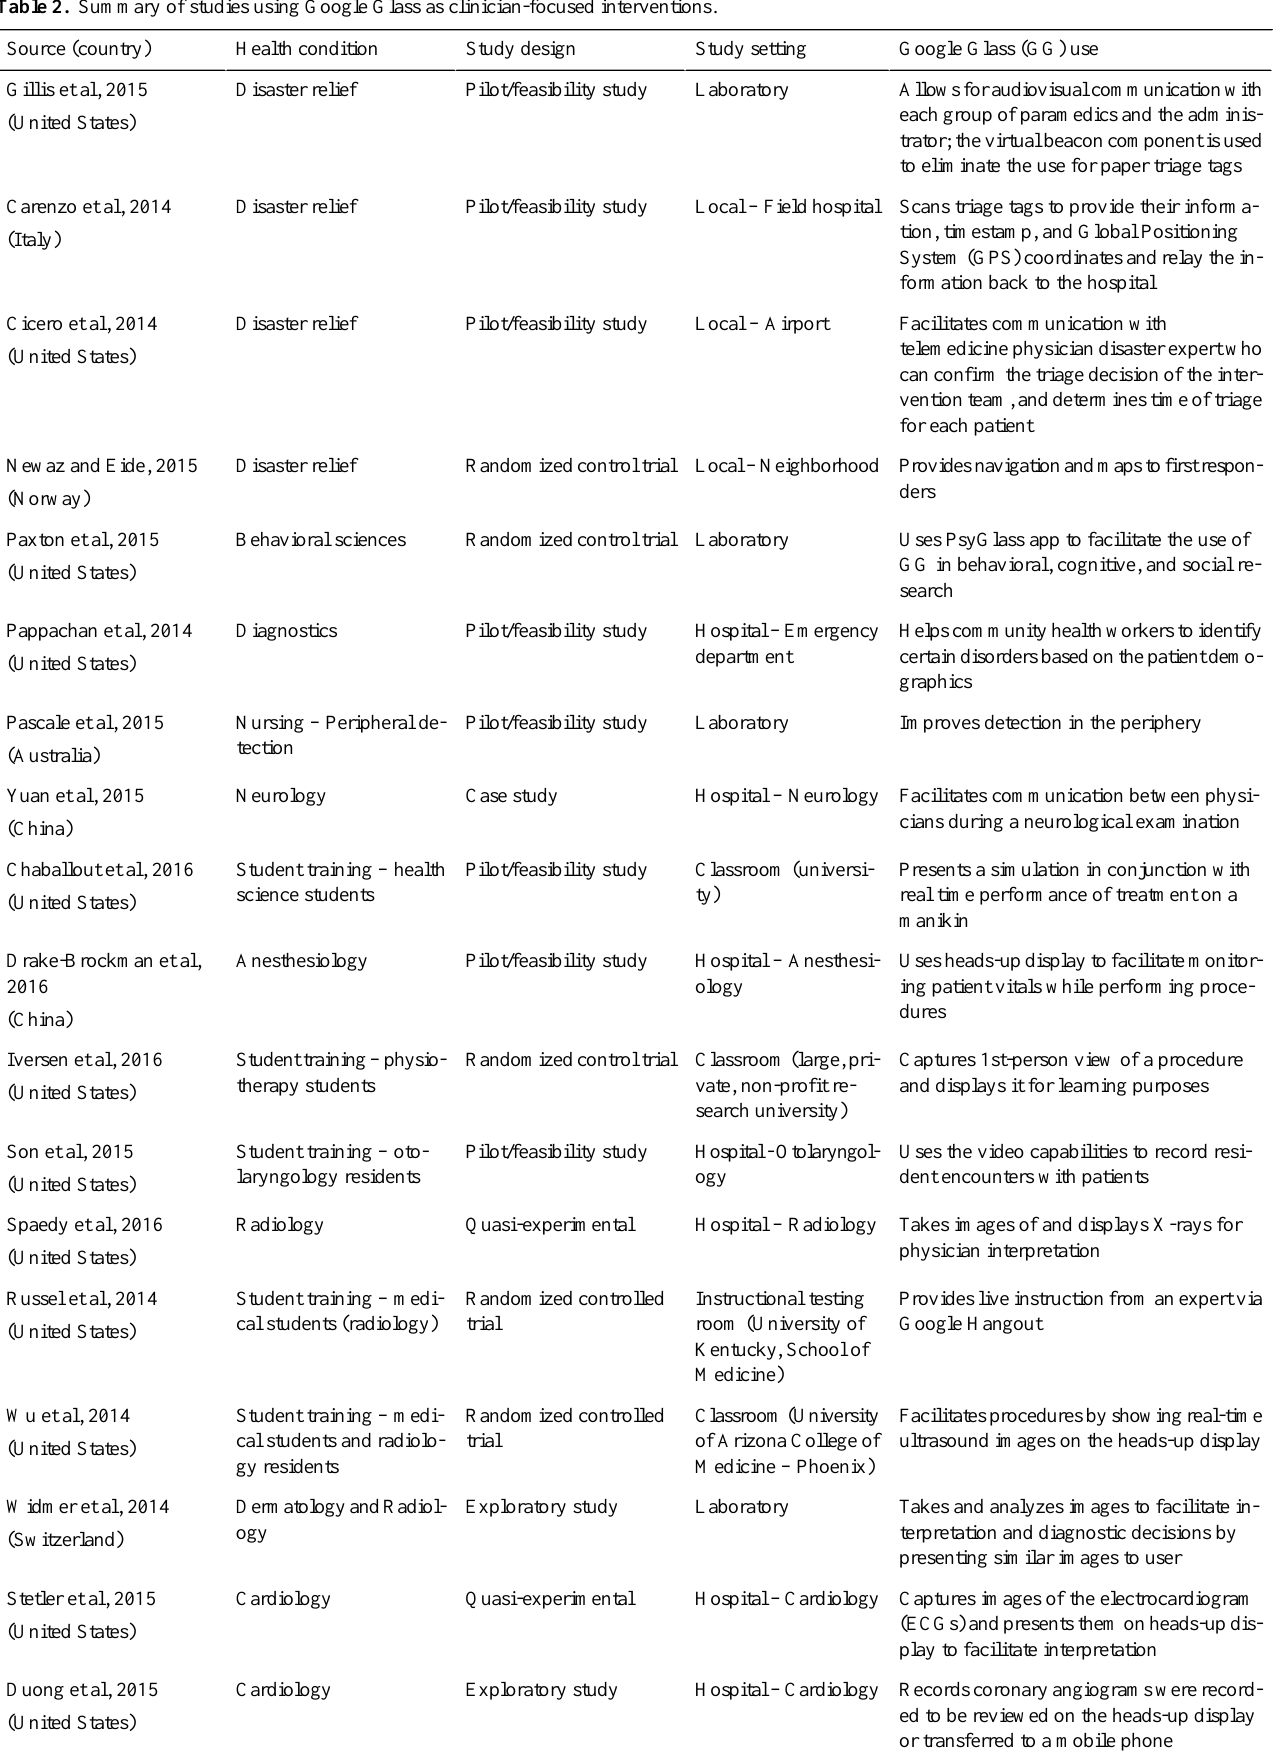
Table 2. Summary of studies using Google Glass as clinician-focused